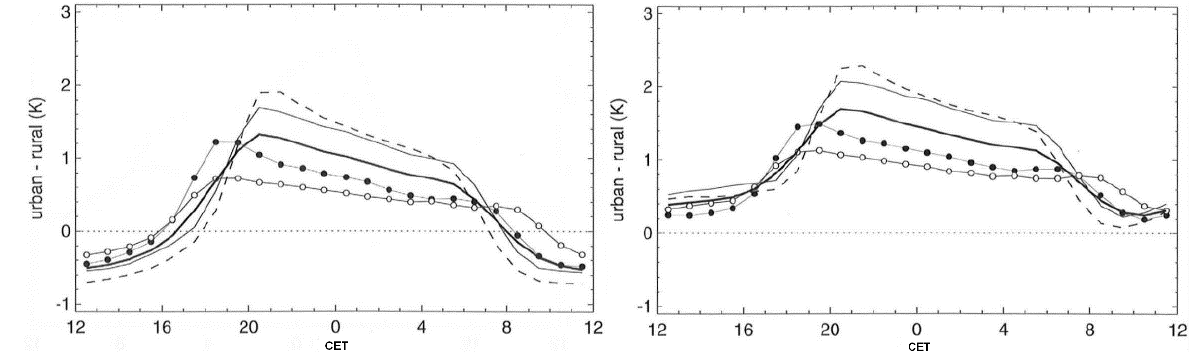
Figure 4. Mean diurnal course of air temperature differences (urban–rural) for the period 1994–2003 between the urban flux stations Basel-Spalenring (roof level, 32 m AGL) and the rural station Basel-Lange Erlen (2 m above ground) (left), and Basel- Spalenring (street level, 3 m AGL) and Basel-Lange Erlen (2 m AGL) (right) (–– spring, - - - summer, ● - ● autumn, ◦ - ◦ winter, and –– annual mean) [29]. Note that time axes (X-axes) are midnight centered (X-axis in Central European Time).